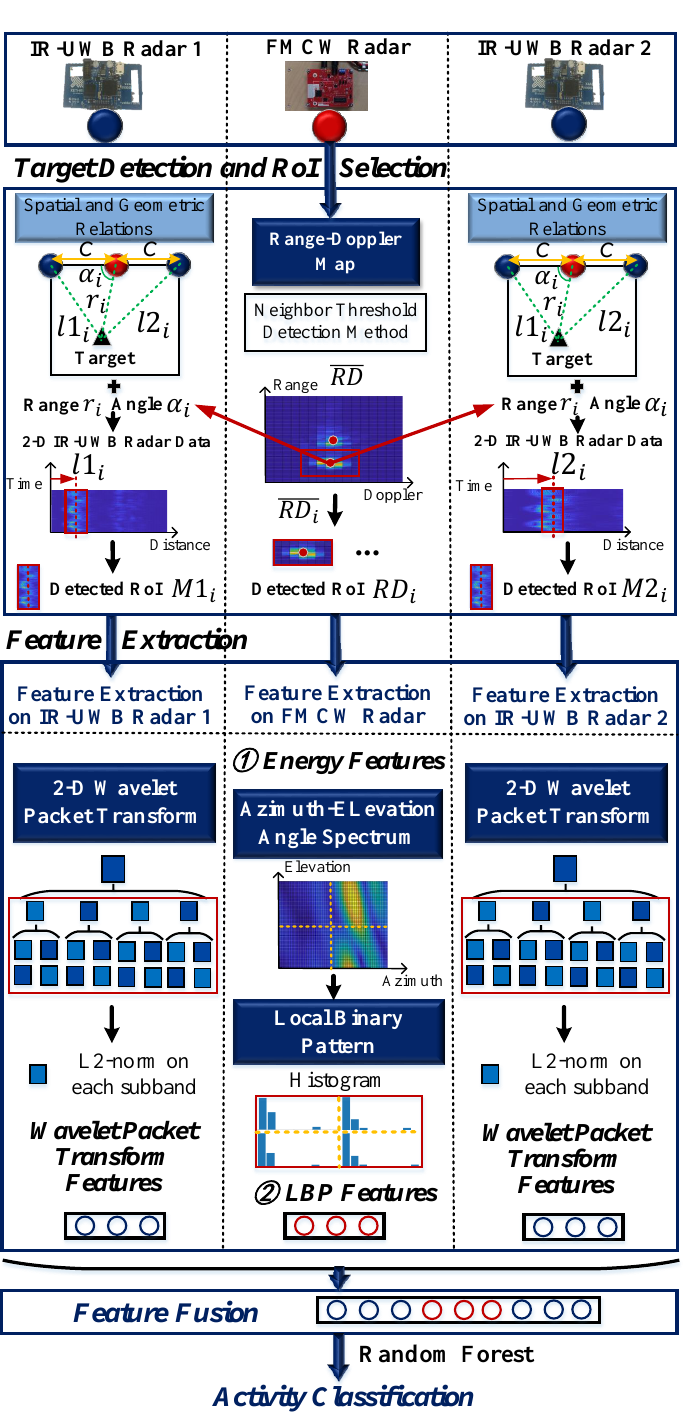
Figure 4. Schematic diagram of proposed feature extraction and fusion for activity